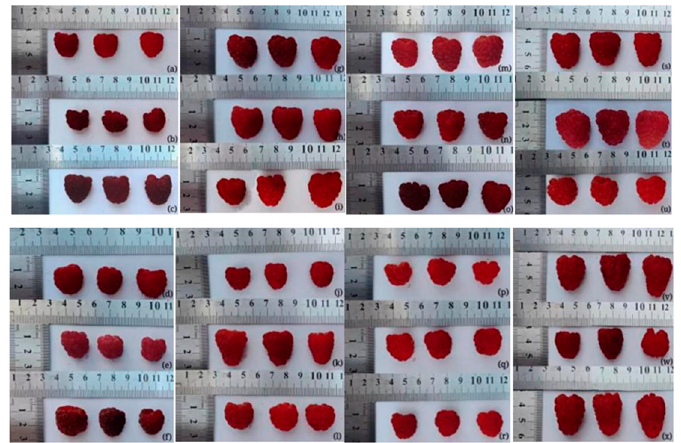
Figure 1. The size and shape of 24 red raspberry varieties. ( a ): ‘European red’, ( b ): ‘Beijing21 ′ , ( c ): ‘Boyne’, ( d ): ‘DNS9 ′ , ( e ): ‘Beijing19 ′ , ( f ): ‘Summit’, ( g ): ‘Beijing32 ′ , ( h ): ‘Beijing10 ′ , ( i ): ‘Nootka’, ( j ): ‘Fertod zamatos’, ( k ): ‘DNS4 ′ , ( l ): ‘DNS2 ′ , ( m ): ‘Samodiva’, ( n ): ‘DNS1 ′ , ( o ): ‘Royalty’, ( p ): ‘Tu- lameen’, ( q ): ‘Canby’, ( r ): ‘Bulgaskc’, ( s ): ‘Ruby’, ( t ): ‘Heritage’, ( u ): ‘Schopska’, ( v ): ‘DNS5 ′ , ( w ): ‘Willamette’, ( x ): ‘Rerille’.